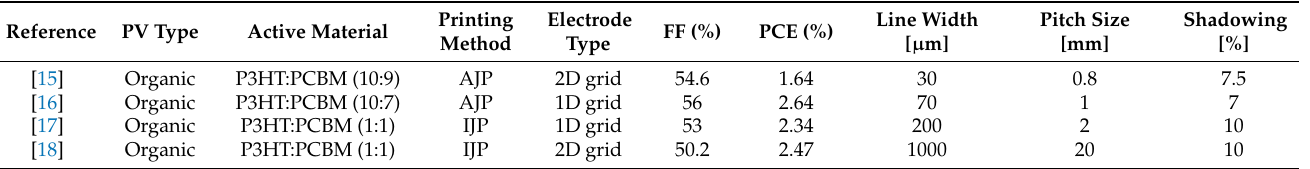
Table 1. Recent achievements connected with additive manufacturing technologies’ application in photovoltaic research. Reference PV